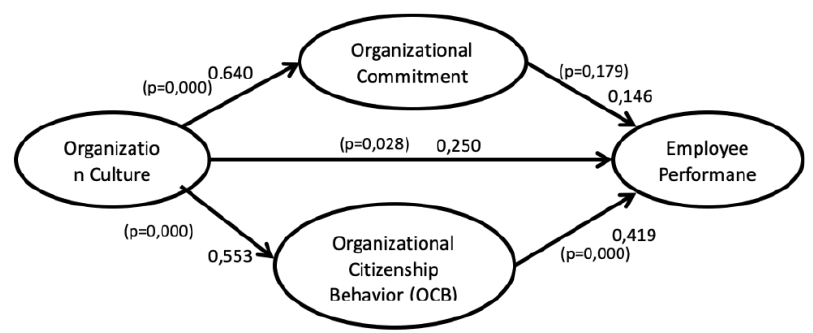
Figure 2: Direct Effect Testing Results; Source: Processed primary data,